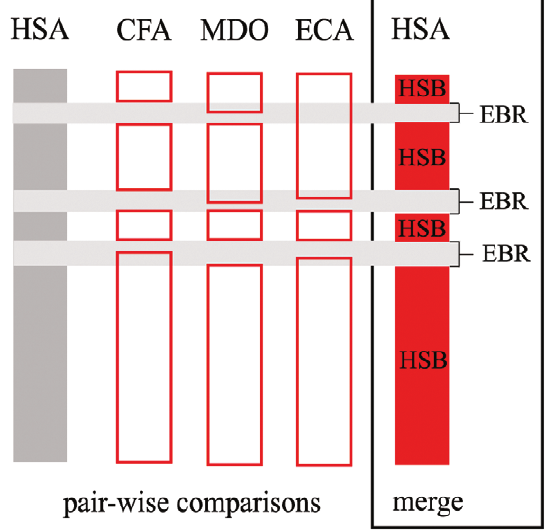
Figure 1. Representation of how homologous synteny blocks (HSBs) and evolutionary breakpoint regions (EBRs) are defined in the human genome. Comparing two genomes at a time, we established pair-wise EBRs. Then, we merged those EBRs that overlap in the same human region, obtaining merged EBRs and HSBs. Abbrevi- ations –PTR: Pan troglodytes , ECA: Equus caballus , MDO: Monodelphis domestica , HSA: Homo sapiens . doi:10.1371/journal.pone.0027239.g001 PLoS ONE |